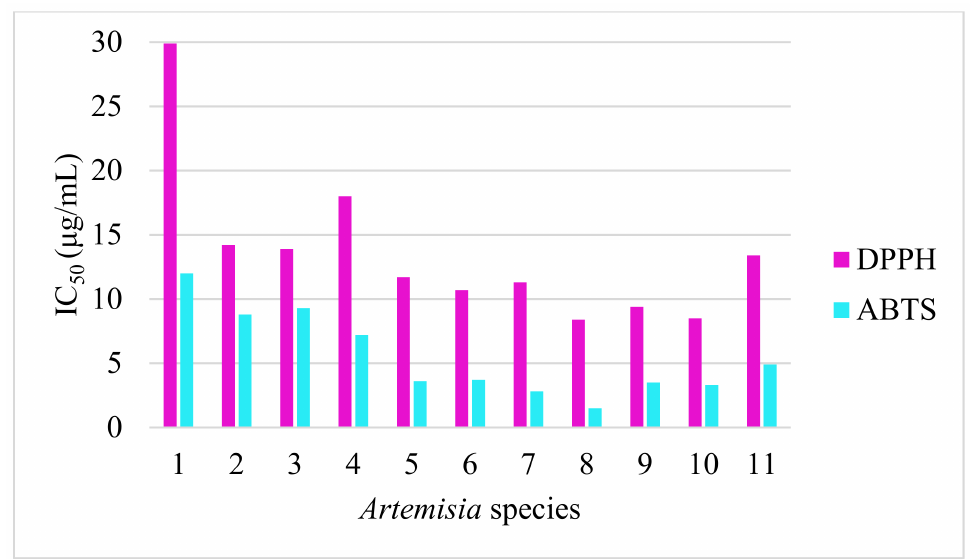
Figure 4. TPC and TFC of Artemisia species.